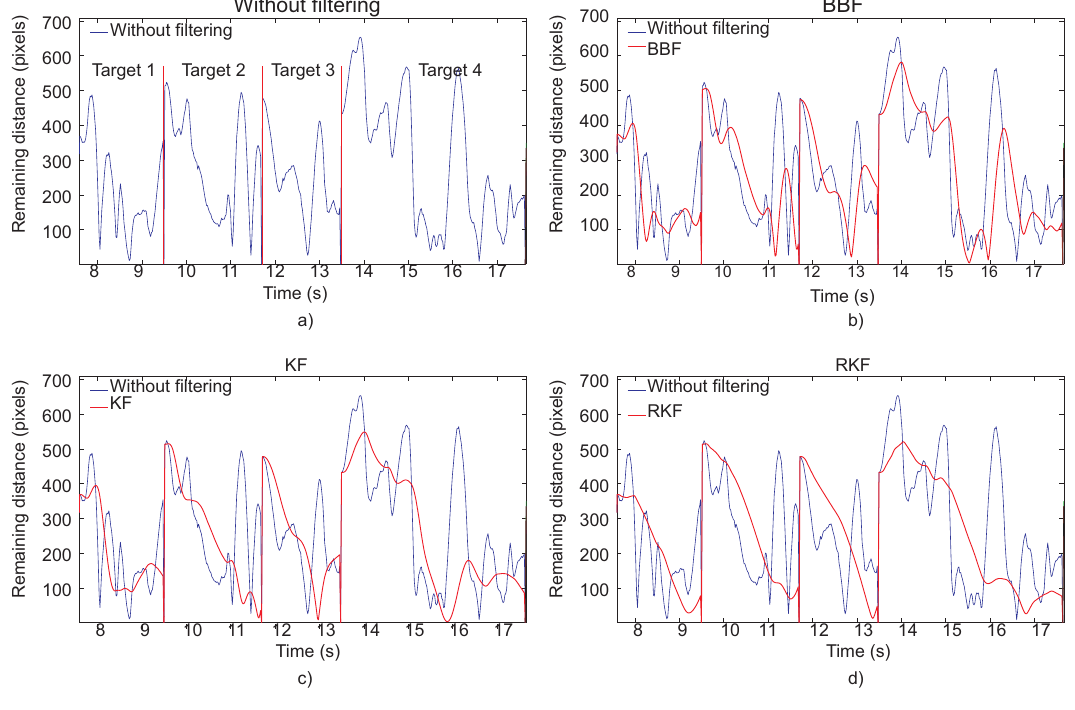
Figure 8. Remaining distance versus time for 4 consecutive reaching tasks performed by CP1, ( a ) without filtering, ( b ) with BBF, ( c ) with KF, ( d ) with